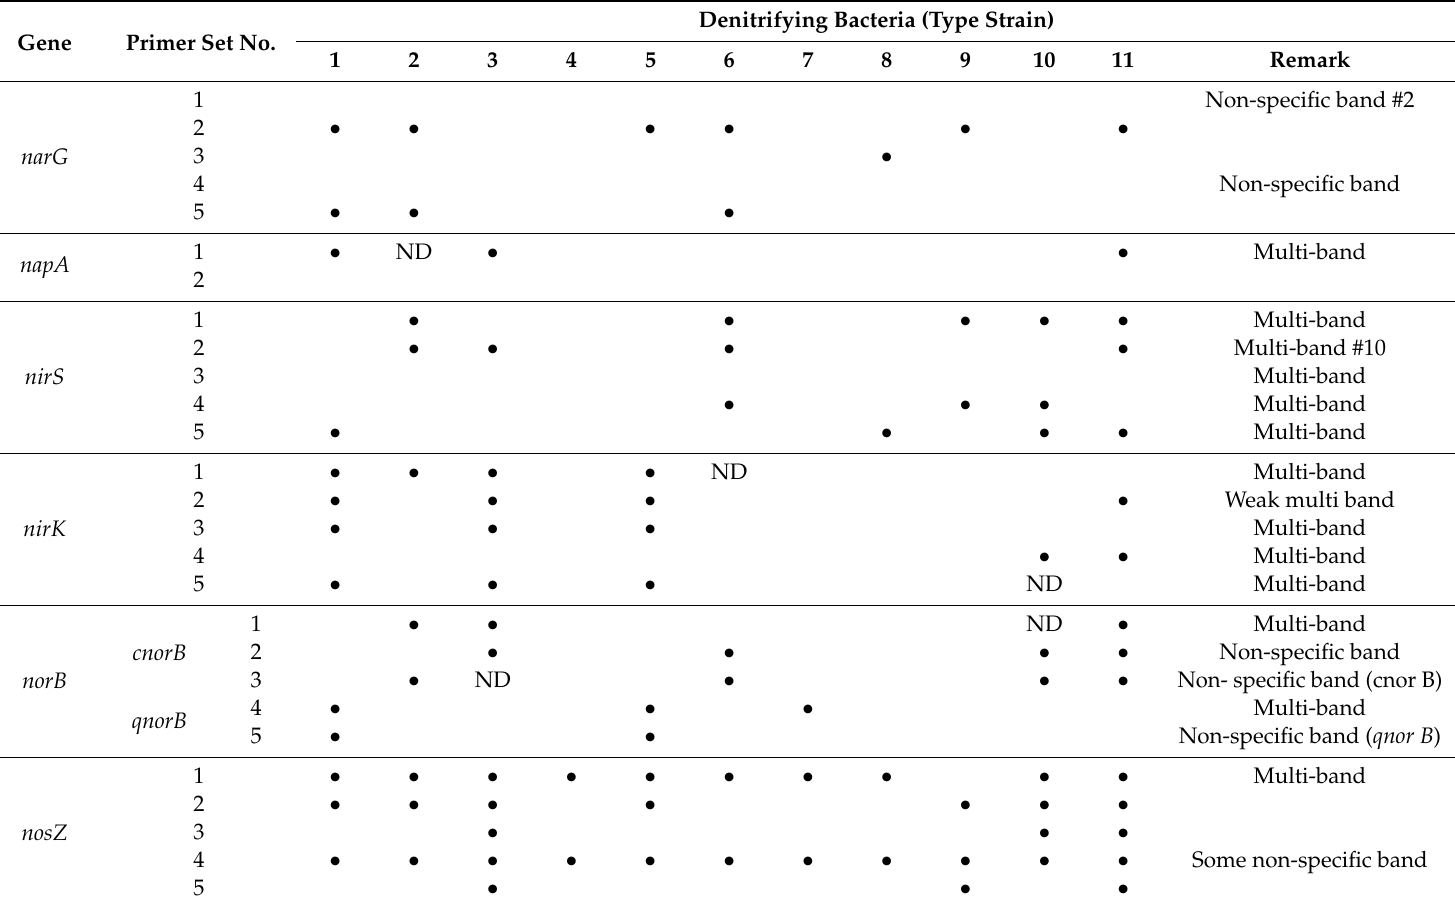
Table 2. Comparison of denitrification-associated gene PCR primer sets using eleven denitrifying bacteria type strains. Gene Primer Set No.